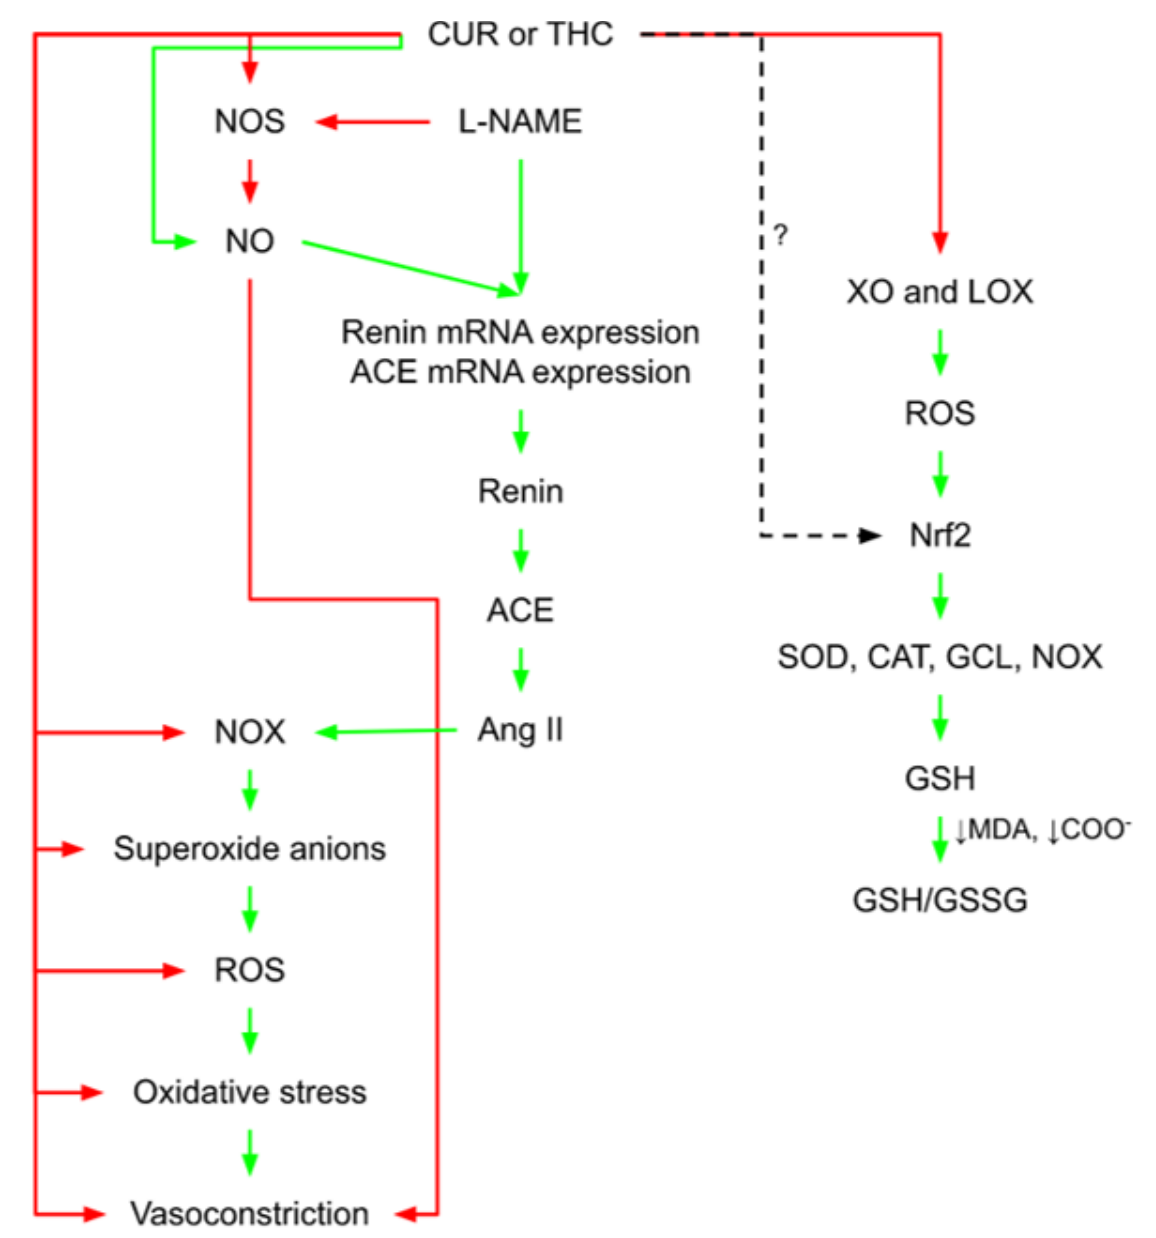
Figure 1. CUR- and THC-related vascular protection in L-NAME-induced hypertension and in the context of NO deficit. CUR activates Nrf2, increasing the expression of antioxidant enzyme genes, such as SOD, CAT, GCL, and NAD(P)H oxidoreductase. CUR and THC both reduce oxidant production by reducing the levels of O 2 − , MDA, and COO-, while endogenous GSH is boosted by raising the GSH ratio in the redox direction. THC does not appear to be able to activate Nrf2. CUR, curcumin; THC, tetrahydrocurcumin; L-NAME, ( ω )-nitro-L-arginine methyl ester; Nrf2, nuclear factor erythroid-derived 2-like 2; SOD, superoxide dismutase; CAT, catalase; GCL, glutamate-cysteine ligase; NAD(P)H, oxidoreductase; O 2 − , superoxide radical; MDA, malondialdehyde; COO-, protein carbonyls; GSH, glutathione; punctuated line, unclear effect; red arrow, inhibitory effect; green arrow, stimulatory effect.